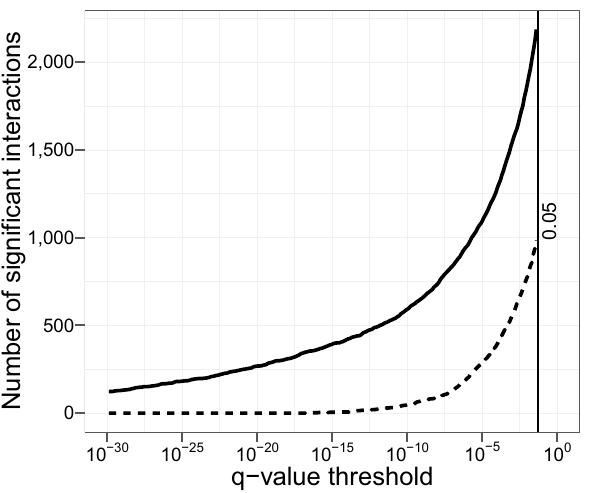
Figure 1. The cumulative number of significant interactions as a function of the critical q -value threshold considered. The solid line signifies positive interactions detected, while the dashed line represents the number of negative interactions.